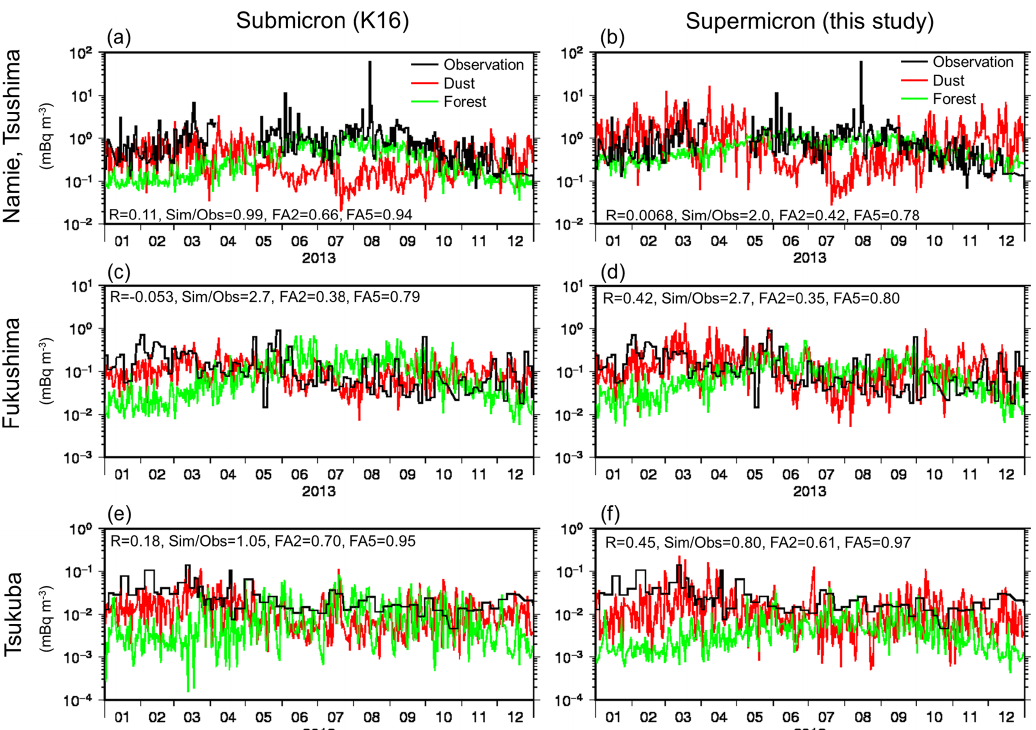
Figure 4. Same as Fig. 3 but for the surface activity concentrations of 137 Cs (mBqm − 3 ). The sampling intervals are used for the observations, but daily mean values are depicted for the